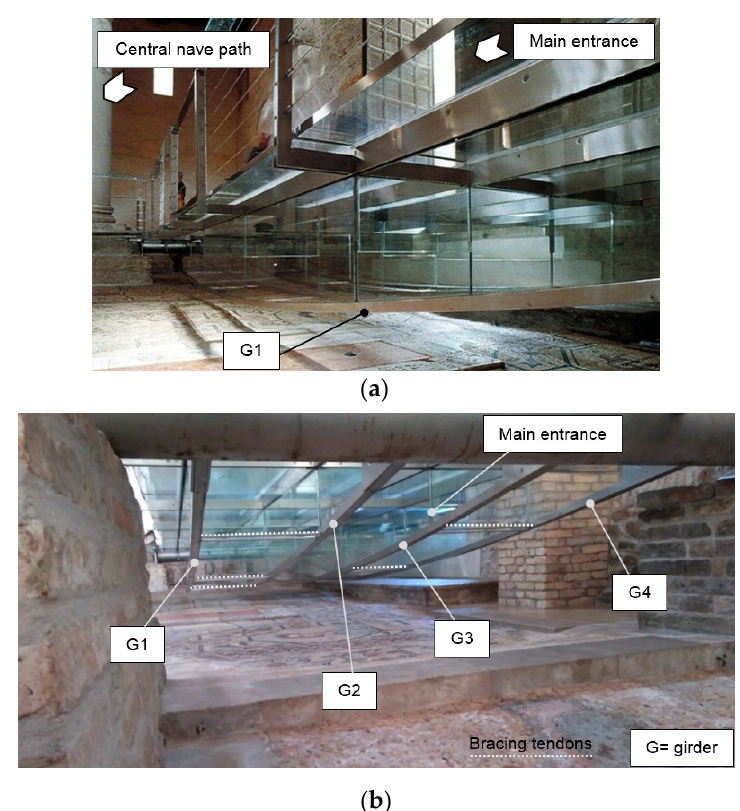
Figure 5. Main entrance suspension platform: ( a ) Front / bottom view and ( b ) detail bottom view, with evidence of longitudinal girders and tendons (photos by C. Bedon, courtesy of So.Co.Ba).